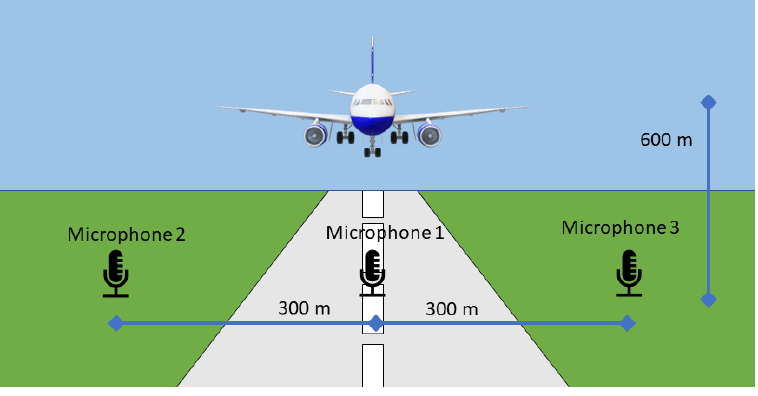
Figure 18. Flyover and measurement in three aligned